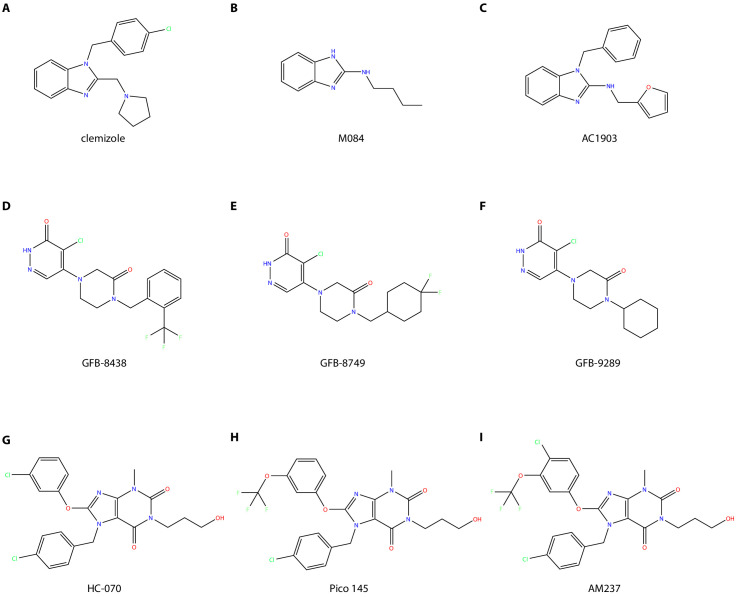
Comparison of chemical structures of different TRPC5 ligands.(A–C) Benzimidazole derivatives inhibitors: clemizole (CMZ) (A), M084 (B), and AC1903 (C). (D–F) Piperazinone/pyridazinone derivatives inhibitors: GFB-8438 (D), GFB-8749 (E), and GFB-9289 (F). (G–I) Xanthine derivatives ligands: inhibitors HC-070 (G), Pico145 (H), and activator AM237 (I).